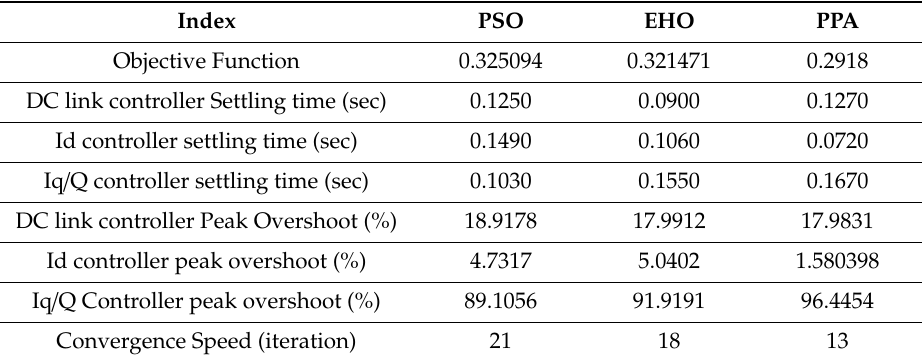
Table 5. Objective function, time responses and convergence speed of di ff erent